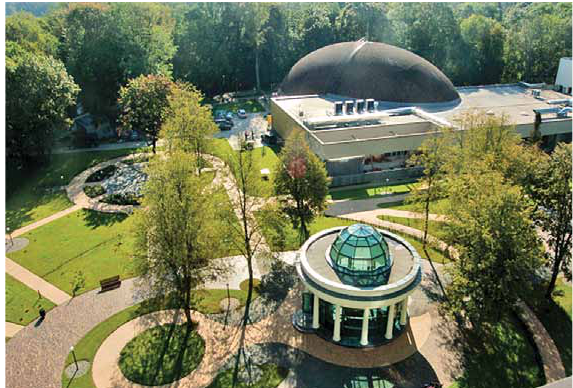
fig. 11. Druskininkai “Grand SPa lietuva” health and relaxation centre: the example of the innovative modernization of the urban complex in